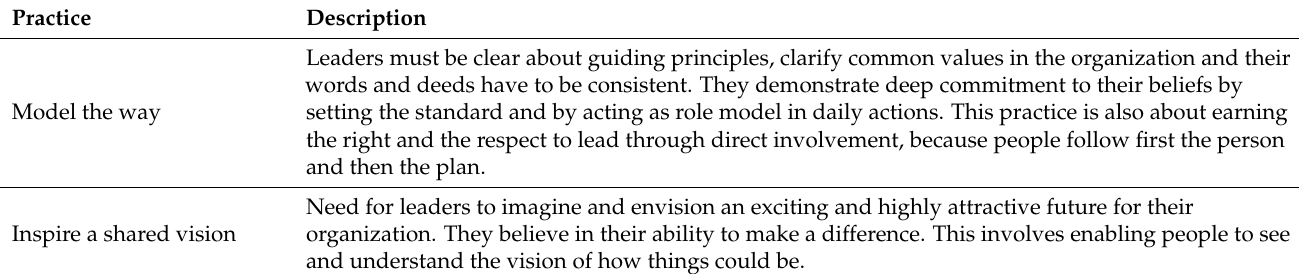
Table 1. The Five Practices of Exemplary Leadership (Kouzes and Posner